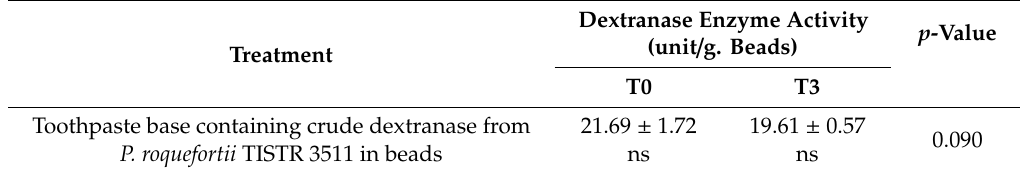
Table 5. The stability of encapsulated fungal dextranase based on its activity in alginate beads of toothpaste base.